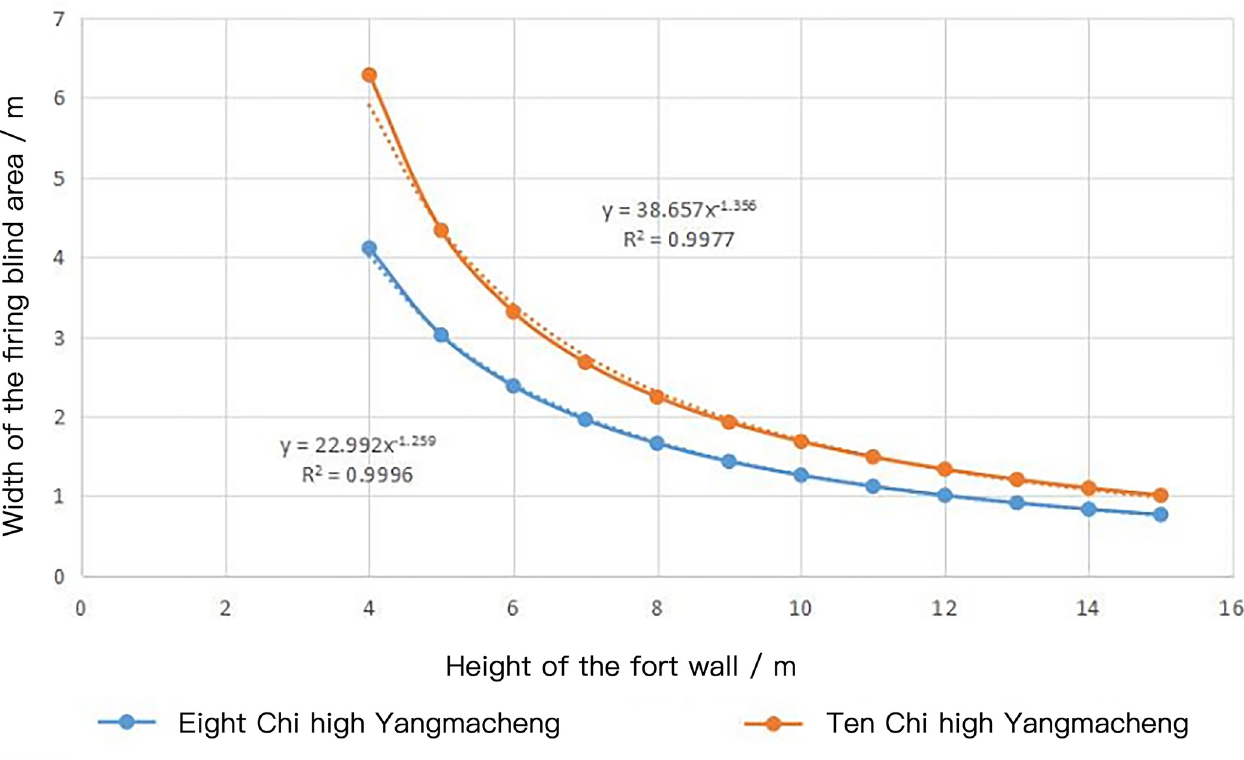
Fig 13. Graph of firing blind area length under different wall